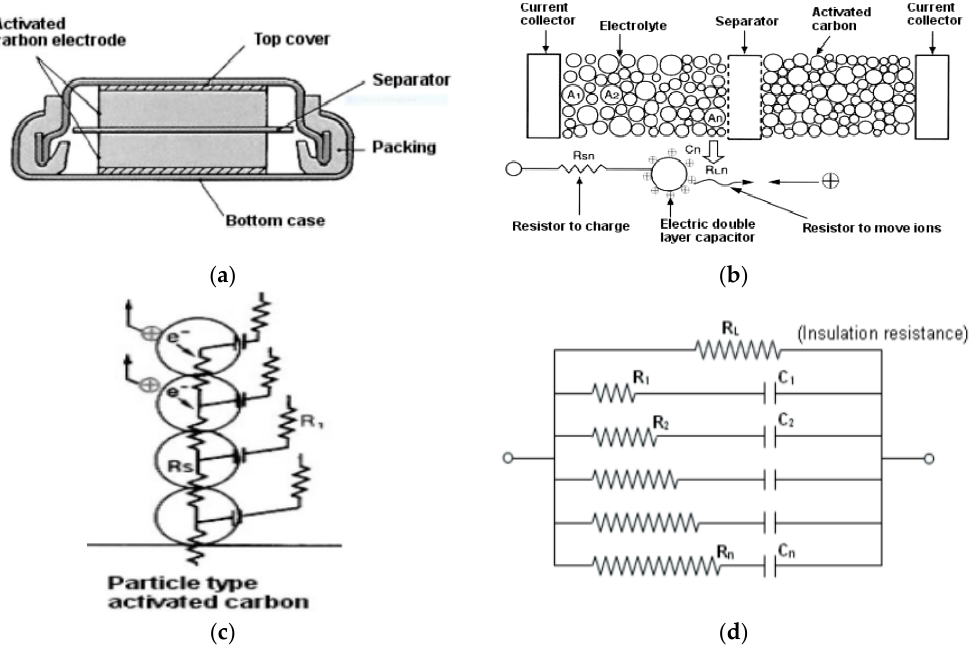
Figure 2. Cross-section of a button-type super-capacitor ( a ); nanometer-scale operating principle of a SC ( b ); circuital model related to the physical structure of a SC for overlapped carbon layers ( c ); equivalent electrical circuit of a SC ( d )